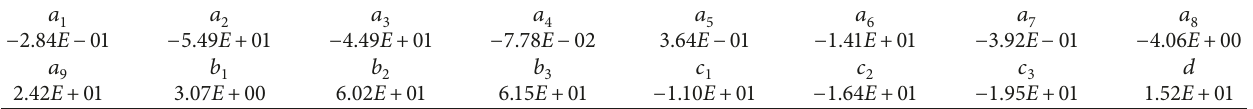
Table 4: Fitting function coefficient.